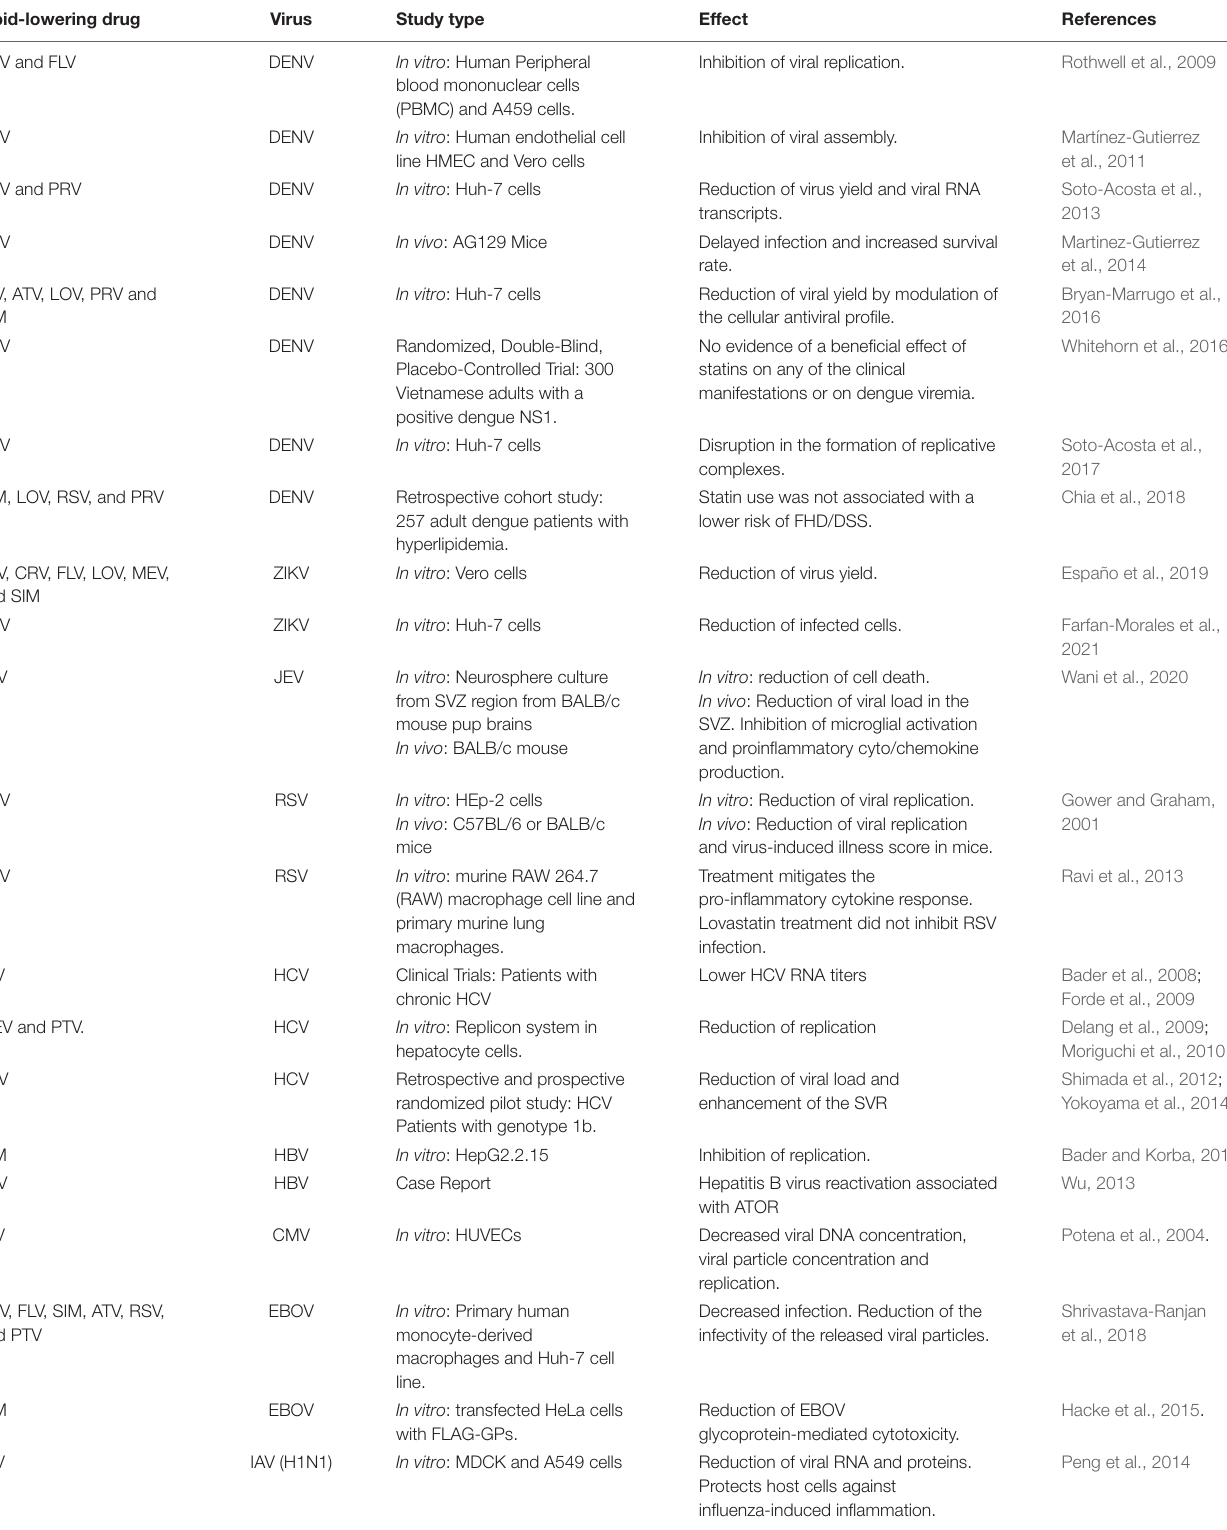
TABLE 1 | Study of the antiviral effect of FDA-approved drugs, STAs, EZE, and